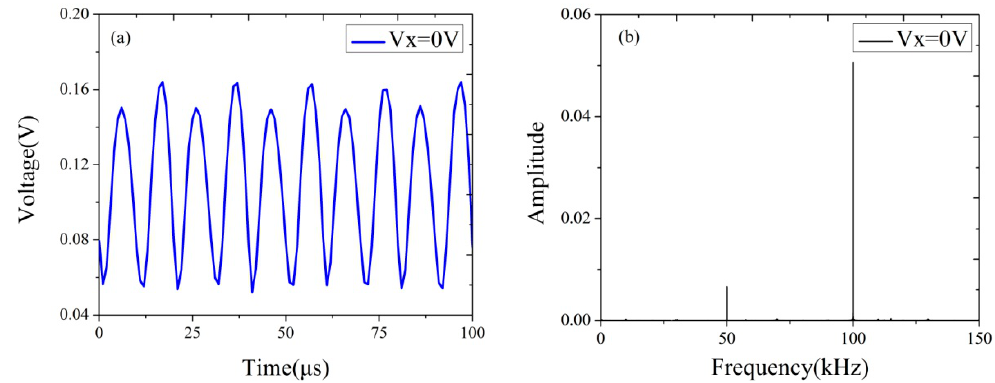
Figure 6. Output voltage of the sensor without phase modulation in the experiments. ( a ) Output voltage waveform; ( b ) Corresponding frequency spectrum.